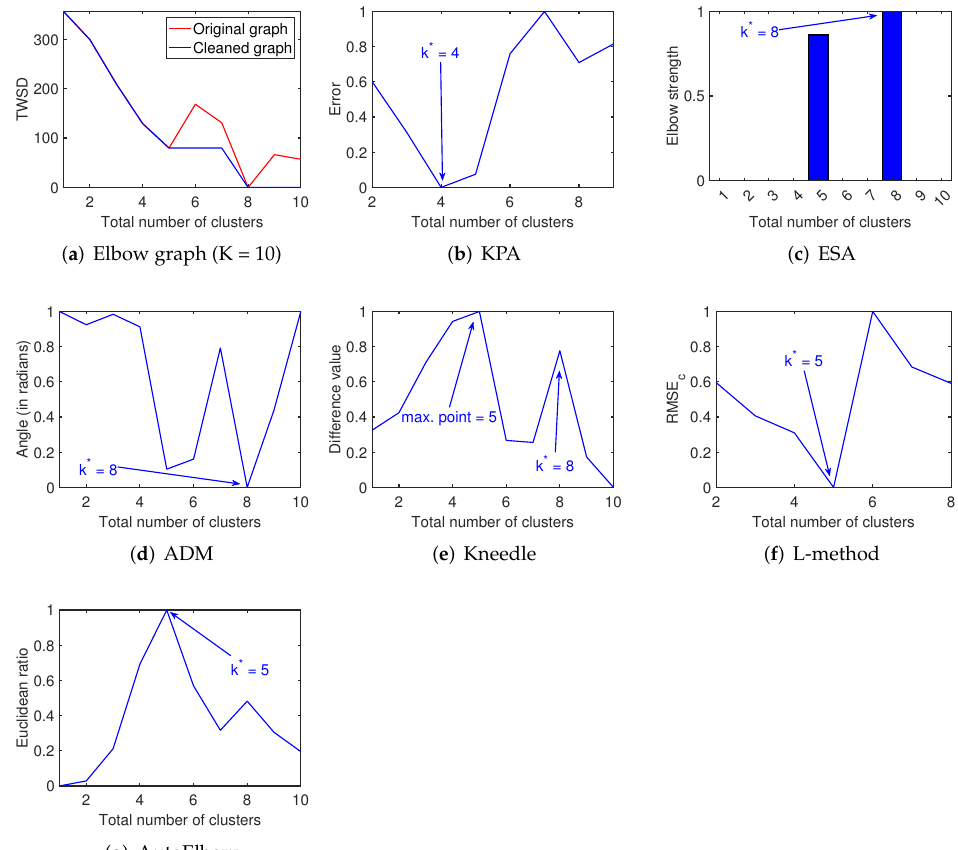
Figure 7. Performance on the high dimension Cleveland data with five